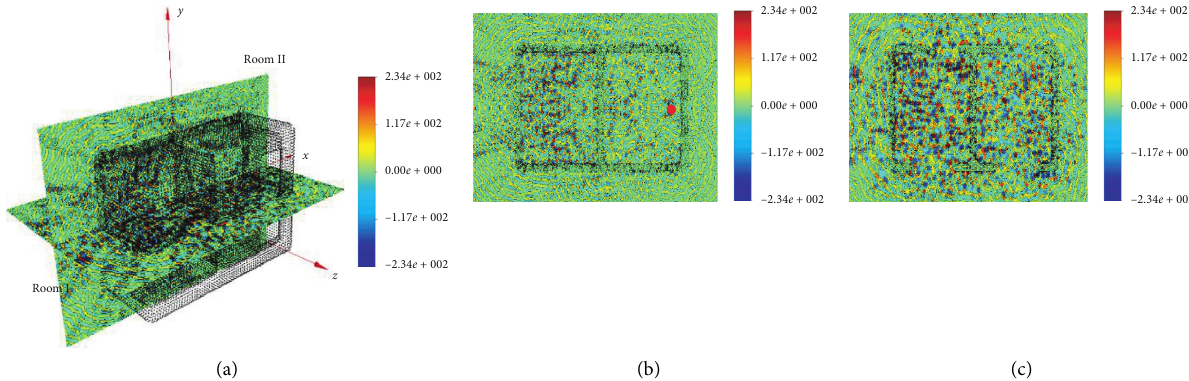
Figure 8: The isometric (a), x - y plane (b), and x - z plane (c) view of the rooms for the source location (1.2 m, 0, Figure 8. The source location is given as a red circle on the figure. The maximum amplitude of the total electric field in the rooms is approximately 1.2 × 10 3 [ V/m ] .